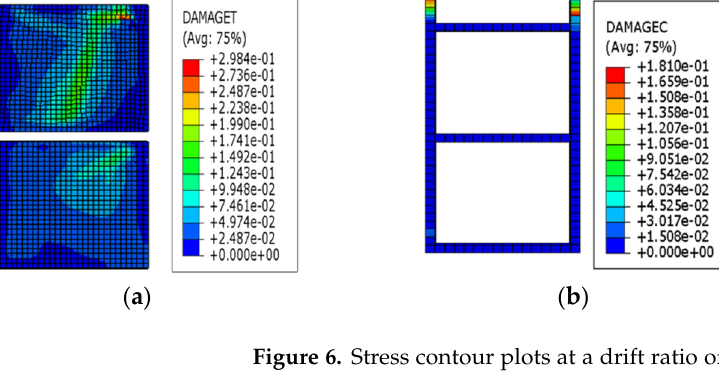
Figure 6. Stress contour plots at a drift ratio of 1/500. ( a ) Stress contour plot of the wall concrete; ( b ) stress contour plot of the concrete in the boundary steel tube; and ( c ) von Mises stress contour plot of the boundary steel tube.